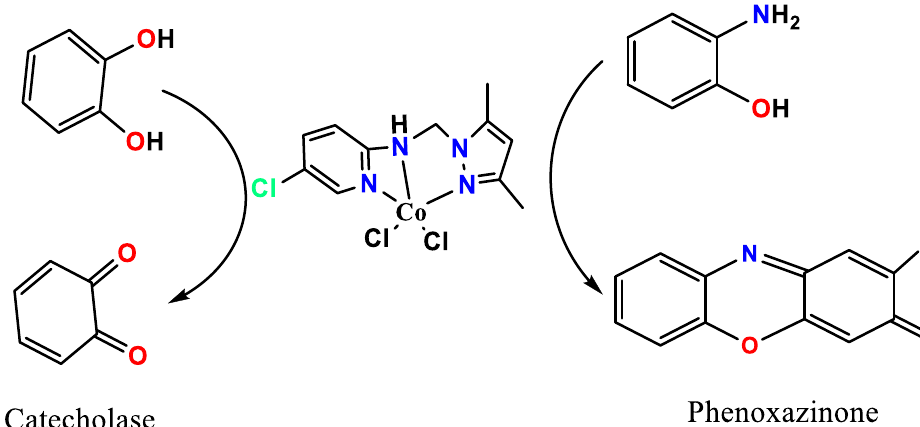
Scheme 2. Catalyzed catecholase and phenoxazinone